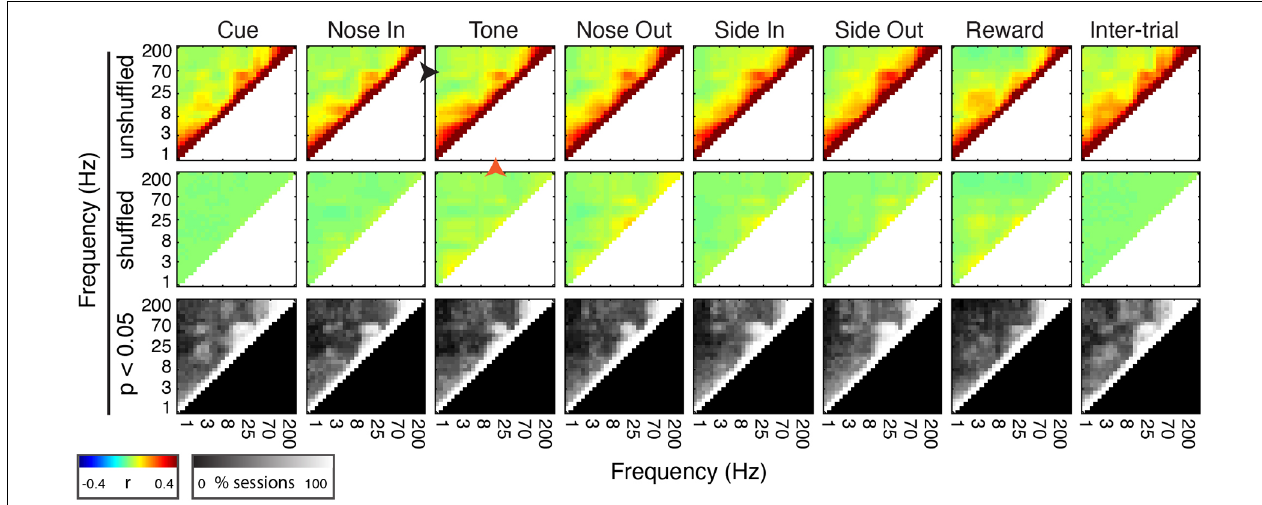
FIGURE 4 | Mthal FP power in discrete frequency bands is comodulated during and between trials. (Top Row) Mean peri-event power-power comodulograms for each behavioral event and during the inter-trial interval for all 30 sessions ( n = 5 rats). There is a consistent positive correlation between continuous beta (20 Hz, orange arrowhead at Tone) and low gamma (55 Hz, black arrowhead at Tone) power. (Middle Row) Comodulograms for the same events calculated using trial-shuffled data. (Bottom Row) Percent of sessions with significant power-power comodulation ( p < 0.05, shuffle test—see “Materials and Methods” section) for each frequency pair.